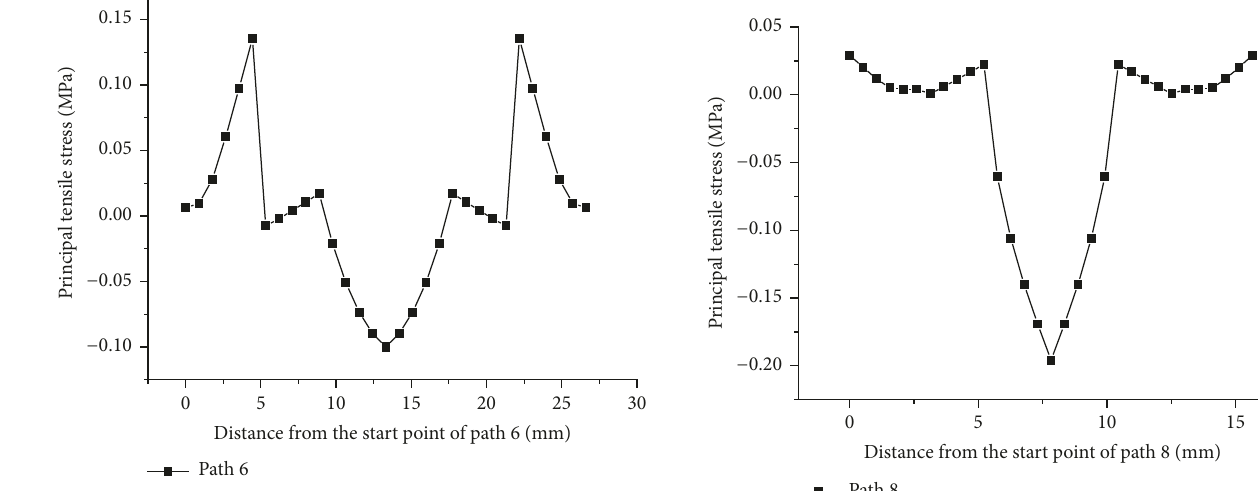
Figure 38: Principal tensile stress in the concrete specimen pre- stressed under a load of 10MPa when the displacement resulting from corrosion-induced expansion reaches 0.031 mm.